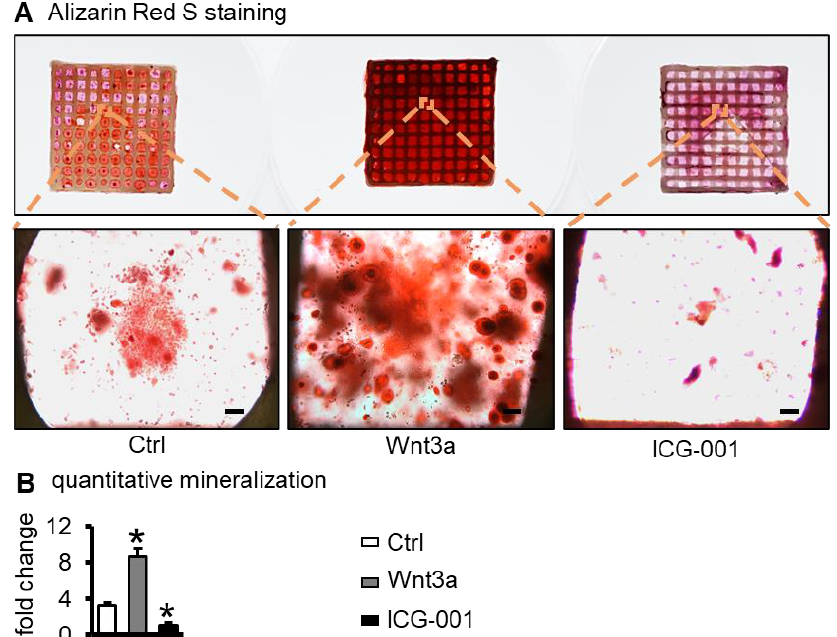
Figure 5. Wnt3a pretreatment enhanced mineralization of ST2/GelMA/PCL scaffolds. After the seventh day of scaffold culture, the scaffolds were induced with osteogenic medium for 21 days. ( A ) Alizarin red S staining and ( B ) mineralization quantitation. Compared with the ctrl group, * p < 0.05 by one-way ANOVA. n = 3. (Scale bar: A, 100 µm). 2.5. Wnt3a Pretreated Bone Repair Scaffold Accelerates Critical-Size Bone Defect Repair The critical-size bone defect of mice parietal bone was used to verify the repair effect of bone tissue engineering scaffolds in vivo [32]. Eight weeks after surgery, compared with the control group, μCT results showed that the Wnt3a group had the best bone repair effect, and the ICG-001 group had the weakest effect (Figure 6A,C). No ectopic bone for- mation was seen on the HE staining of the tissue section at the bone defect position (Figure 6B). Compared with the control group, the bone tissue volume fraction (BV/TV) in the Wnt3a group (Wnt3a group vs. ctrl group: (22.43 ± 3.07)% vs. (8.48 ± 0.91)%, p < 0.05), and osteoblast number per tissue area (N.Ob/T.Ar) in the Wnt3a group (Wnt3a group vs. ctrl group: (7.13 ± 0.93) 10 −2 /mm 2 vs. (3.78 ± 0.95) 10 −2 /mm 2 , p < 0.05) increased significantly. However, BV/TV (3.35 ± 0.52)% and N.Ob/T.Ar (1.73 ± 0.59) 10 −2 /mm 2 in the ICG-001 group were significantly lower than those in the control group ( p < 0.05) (Figure 6D). These sug- gest that the functionalized ST2/GelMA/PCL bone repair scaffold promoted the repair of parietal critical-size bone defects in mice.